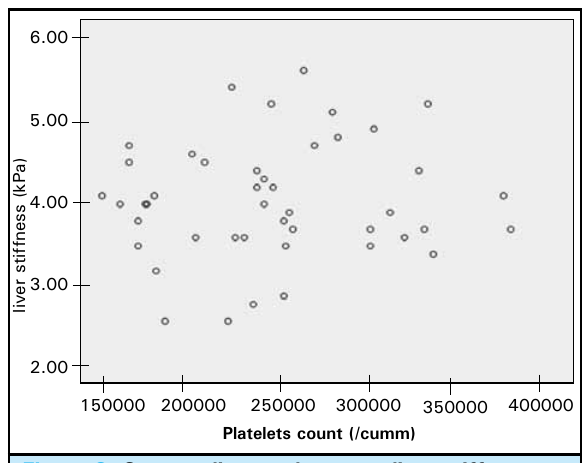
Figure 2. Scatter diagram between liver stiffness and platelet count of the study subjects.